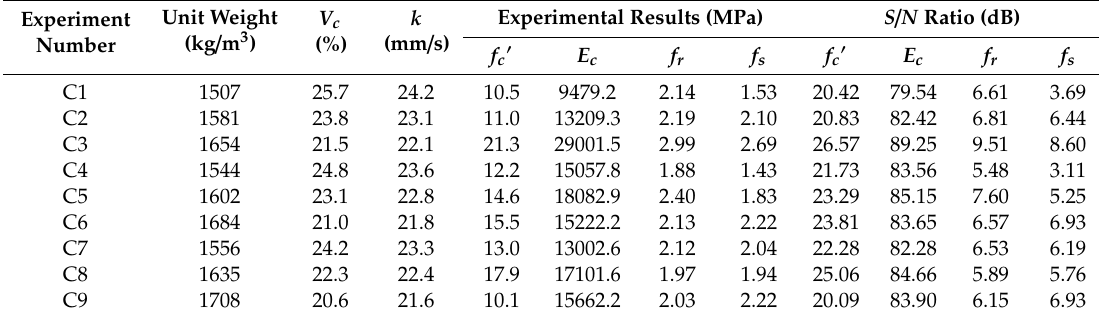
Table 12. Experimental results and S / N ratios of pervious concretes.